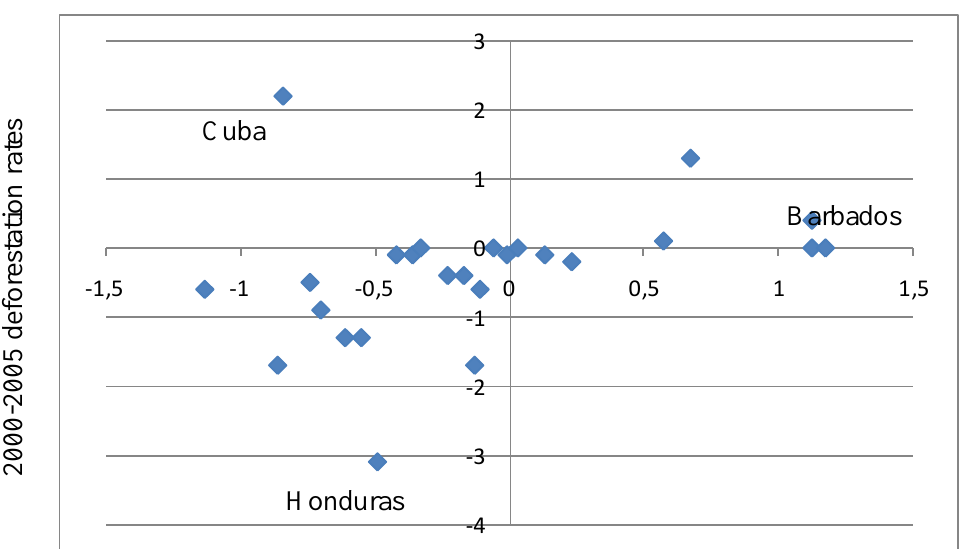
Figure 3. Aggregate governance indicators versus deforestation in Latin America. The aggregate indicators are Voice and Accountability, Political Stability and Absence of Violence/Terrorism, Government Effectiveness, Regulatory Quality, Rule of Law, and Control of Corruption and their values are average relative values of many variables measuring perceptions of governance [48]. Deforestation rates in annual percentage from FAO